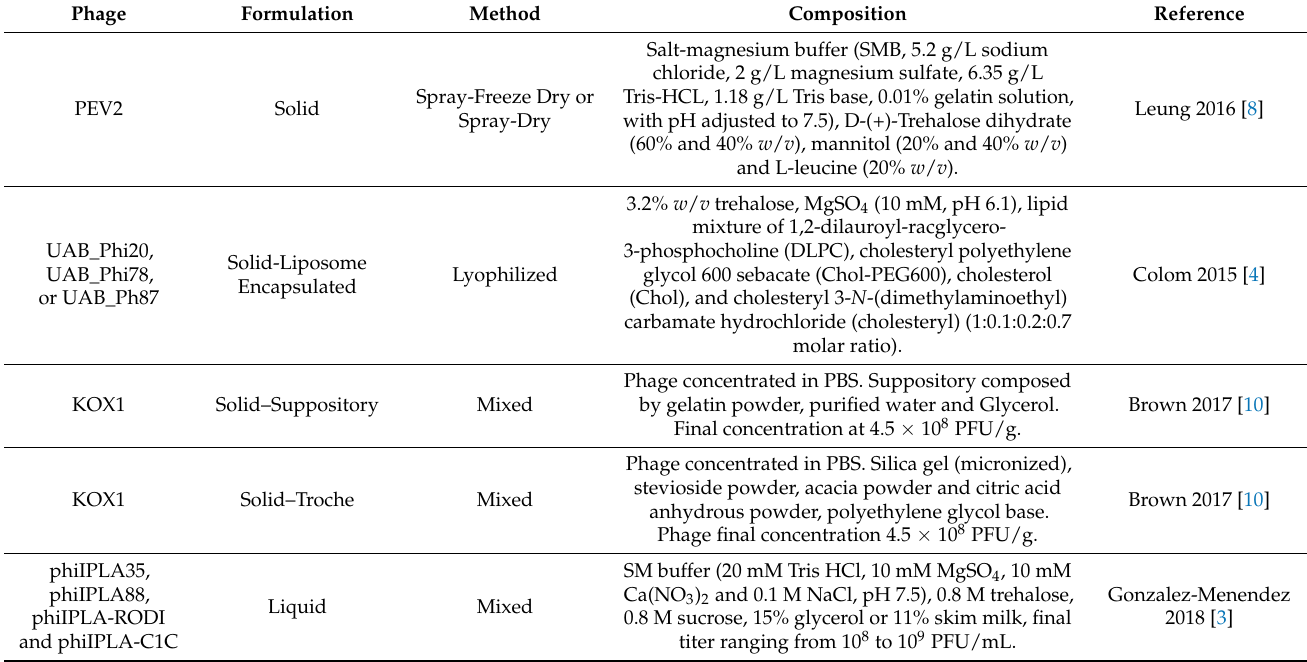
Table 2. Summary of the methods and formulations used for different phages. Gonzalez-Menendez et al., compared distinct formulas between four different phages, two from the Myoviridiae family and two from the Siphoviridiae family [3]. Their stability over a period of 24 months varied across the formulas but were most markedly between the two families. Phage cocktails offer additional challenges as it is necessary to find a formula that works well for all phages present in the cocktail